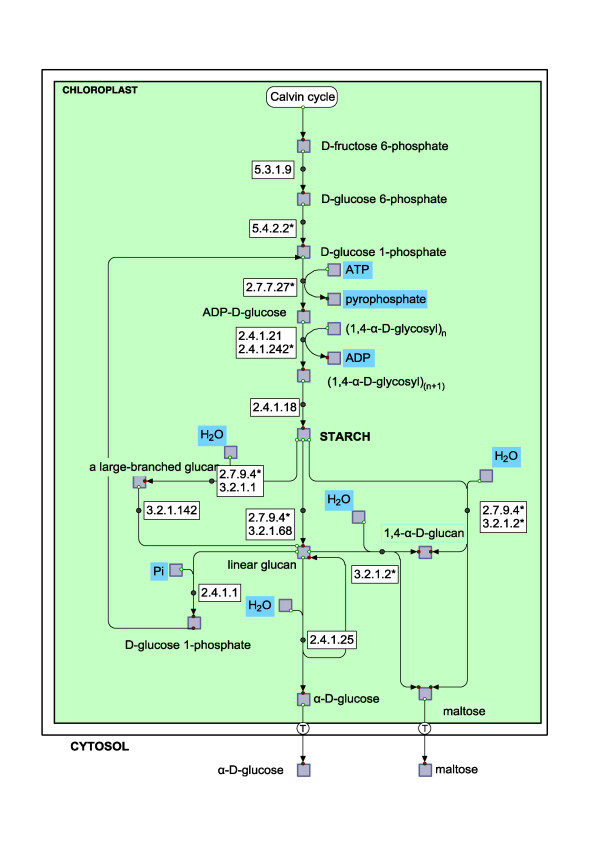
The starch metabolic pathway in to the chloroplast. EC numbers correspond to the respective enzymes: 5.3.1.9 - Glucose 6-phosphate isomerise (Ot11g02980); 5.4.2.2 - Phosphoglucomutase (Ot15g02630); 2.7.7.27 - ADP-glucose pyrophosphorylase (Ot07g03280, Ot07g02930, Ot20g00490); 2.4.1.21 - Starch synthase (Ot06g03410, Ot13g01250, Ot16g02790, Ot13g01230, Ot16g01560); 2.4.1.242- Granule bound starch synthase (GBSSI )( Ot06g03200); 2.4.1.18- Starch branching enzyme (Ot03g00840, Ot04g04110); 2.4.1.1 -Starch phosphorylase (Ot11g00280, Ot04g02110); 2.4.1.25- Disproportionating enzyme (Ot02g05750, Ot02g05750, Ot11g02300); 2.7.9.4- α-glucan, water dikinase (GWD) (Ot13g01510, Ot16g02370, Ot04g04170, Ot08g01260); 3.2.1.1 - α-amylase (Ot16g00380, Ot02g05490, Ot10g00260, Ot07g02010); 3.2.1.2 - β- amylase (Ot02g06980, Ot03g03190, Ot03g03170); 3.2.1.68- Isoamylase (Ot14g02550, Ot12g00310); 3.2.1.142- Pullulanase (Ot01g03030); MEX1- maltose transporter (Ot09g03160). Asterisks* point out the potential targets for the genetic regulation revealed by the simulations.